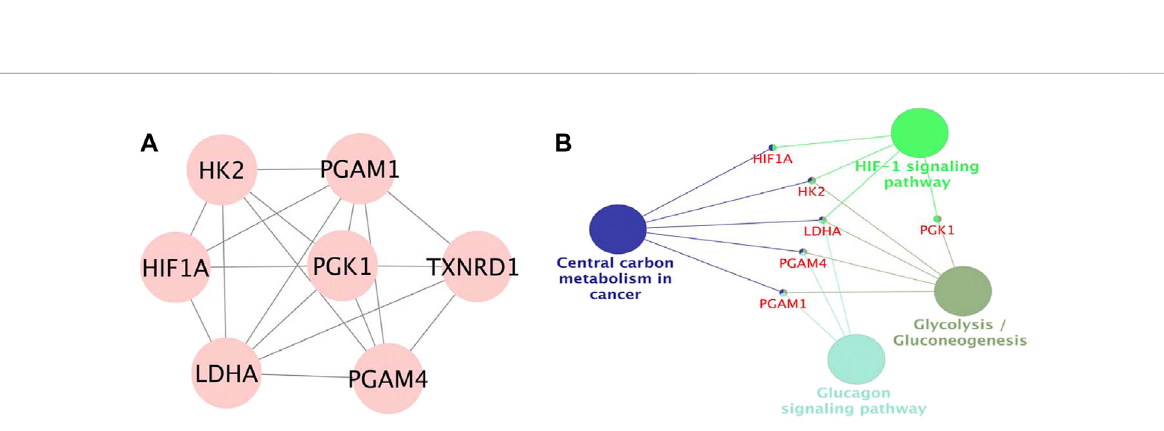
FIGURE 6 (A) . Module in MCODE analysis, the clustering score was 6.0. (B) . KEGG pathway analysis of the